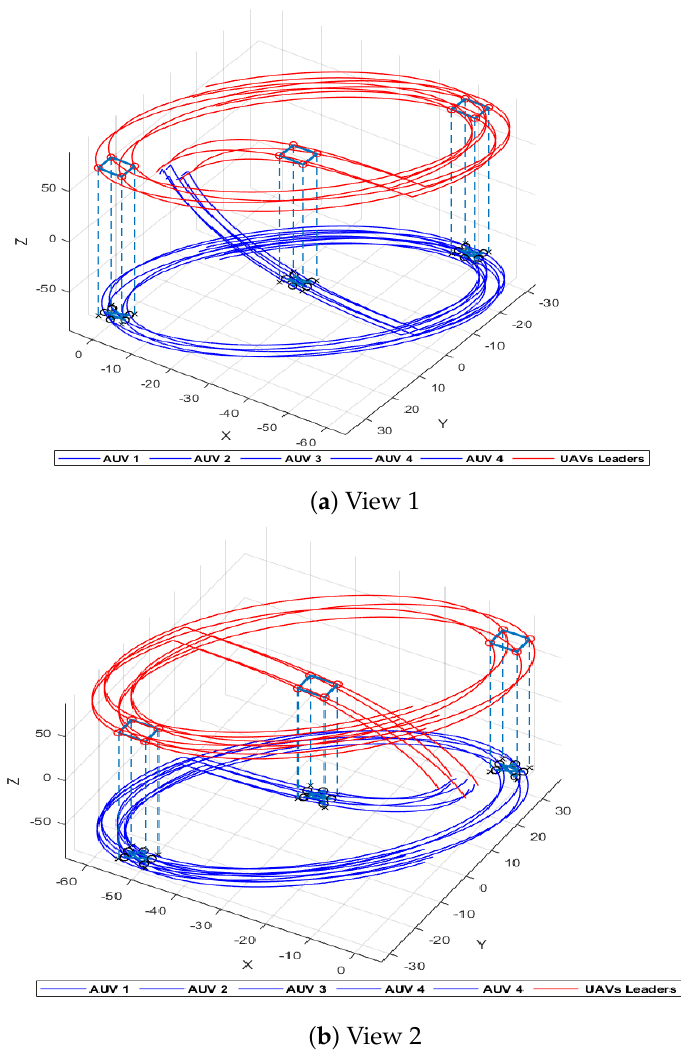
Figure 12. The containment control of five AUVs in star formation within their four UAVs leaders in a square formation under disturbance and uncertainty in 3D space. The dashed lines project the containment area in the space of